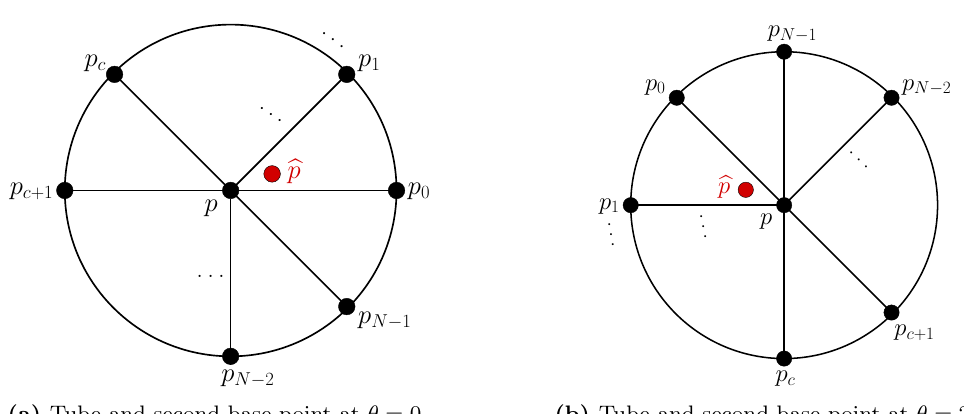
Figure 5. This (cid:12)gure illustrates the motion of the second base point under the permutation induced by the braid. The cone given by p , p 0 and p 1 is moved to the cone originally corresponding to p , p c and p c +1